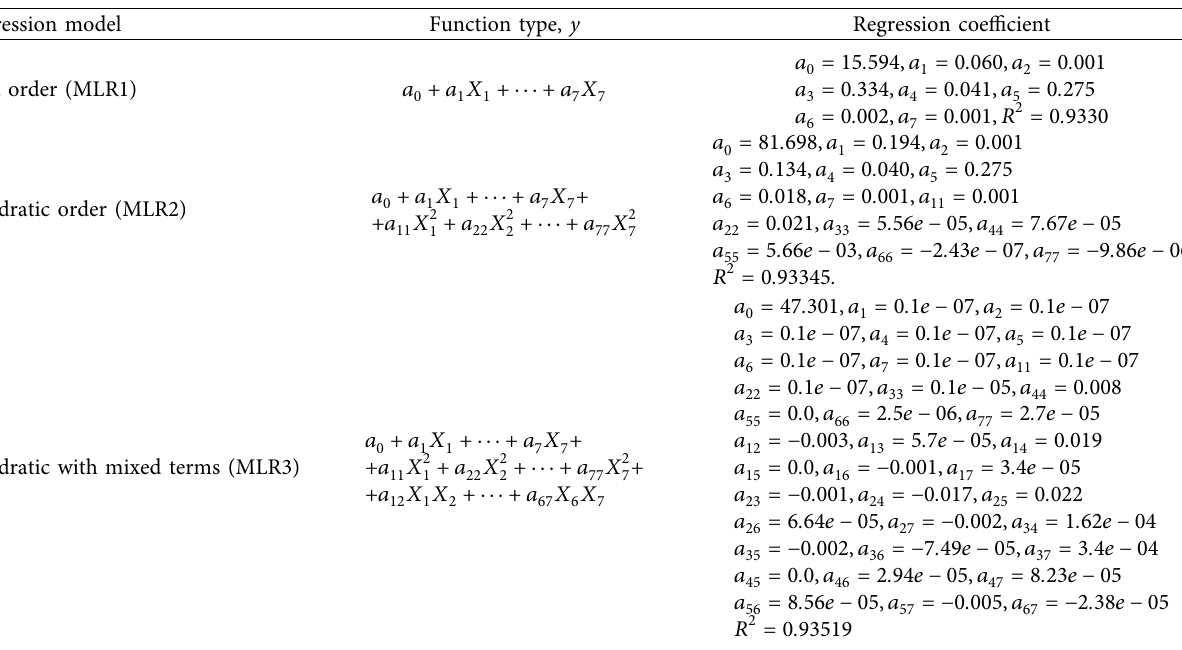
Table 3: Forms and coefficients of three regression